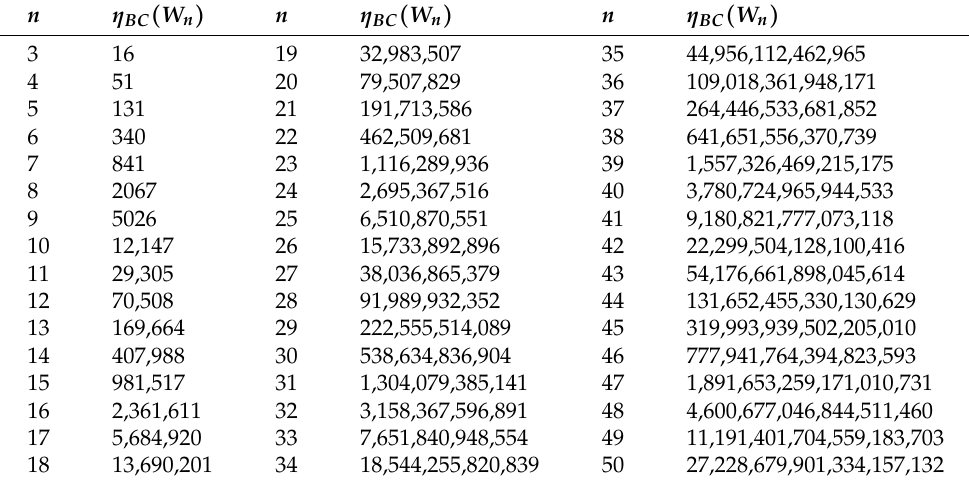
Table 1. The BC-subtree number of wheel graph W n + 1 ( n = 3,4, . . .